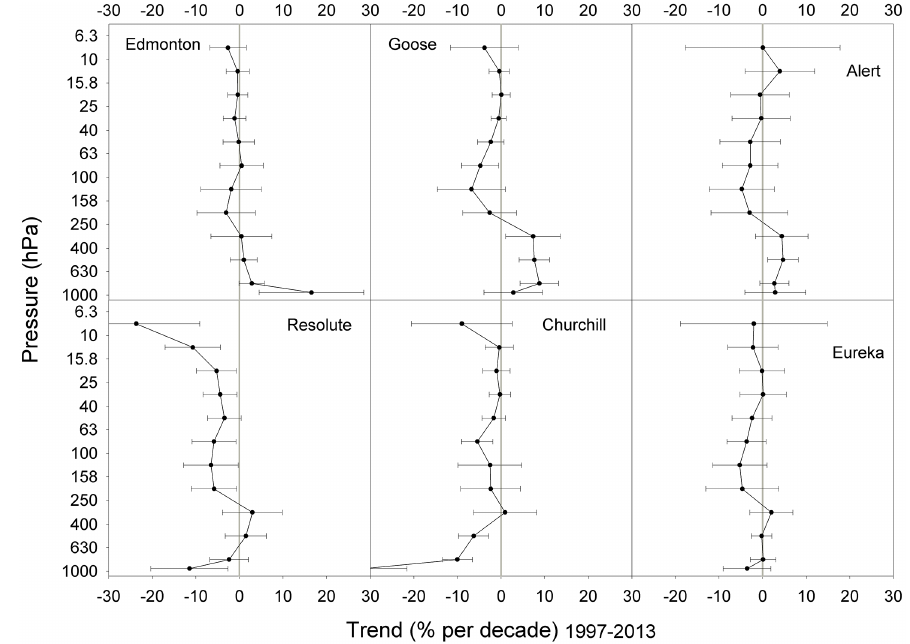
Figure 17. As Fig. 15 but for